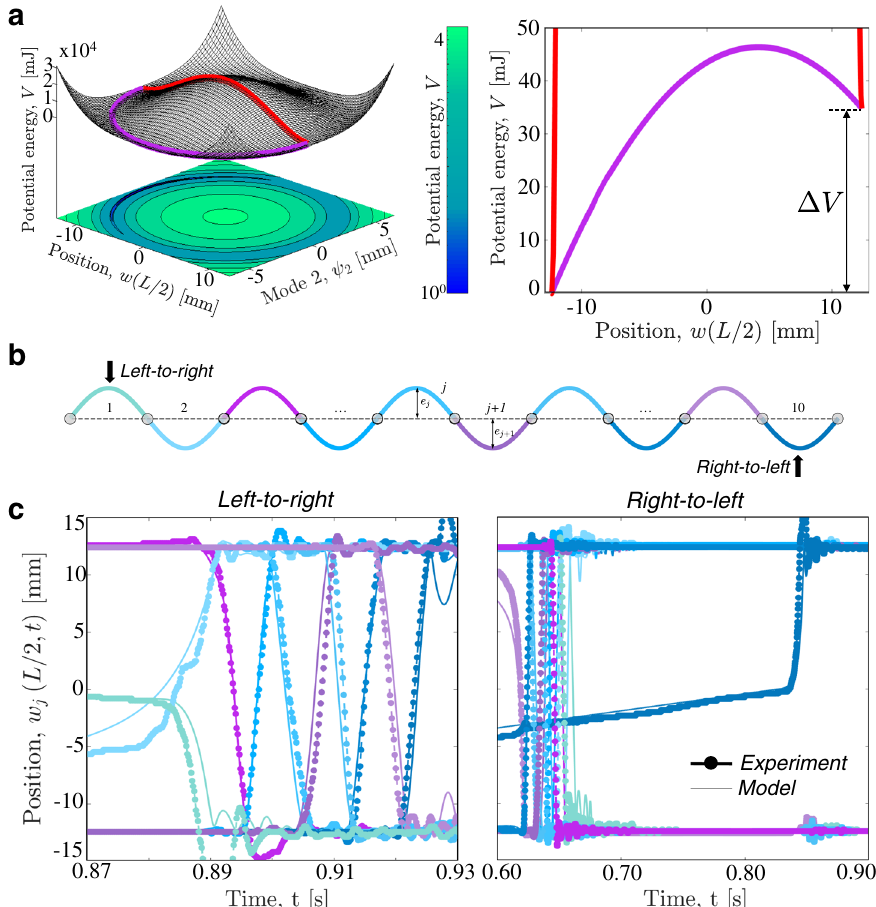
Fig. 4 Symmetric/asymmetric elements — asymmetric array. a On-site energy potential for a plastically deformed shallow arch. The red line indicates a deformation path along which only the fi rst symmetric mode is activated. The purple line corresponds to the minimum energy path. b Schematic of the system with N = 10 shallow arches and one plastically deformed arch arranged every two elastically deformed ones. c Evolution of the positions of the midpoints of the arches, w j ( L /2, t ), for tests in which the indenter acts on the leftmost (left-to-right) and rightmost (right-to-left) arches (see Supplementary Fig. 19 for corresponding numerical contour maps). Thick-dotted and thin lines correspond to experimental and numerical results,